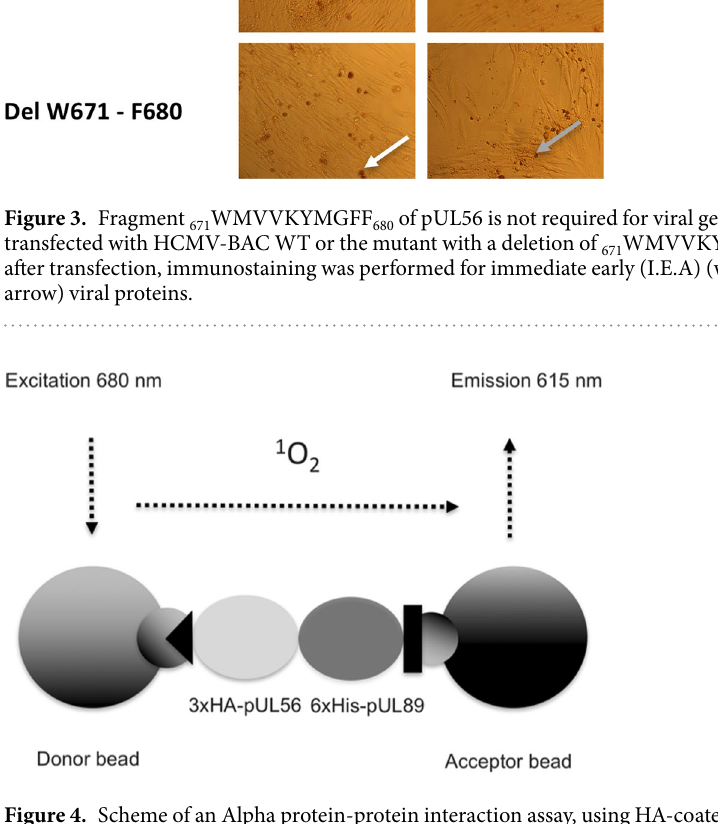
Figure 4. Scheme of an Alpha protein-protein interaction assay, using HA-coated Donor beads, His-coated Acceptor beads, 3xHA-pUL56, 6x His-pUL89. In an Alpha interaction assay, one protein is captured on the Donor beads, and the other protein is captured on the Acceptor beads. In case of interaction, the Donor bead is brought into proximity of the Acceptor bead, and excitation of the Donor bead will result in signal generation dependent on the presence of an